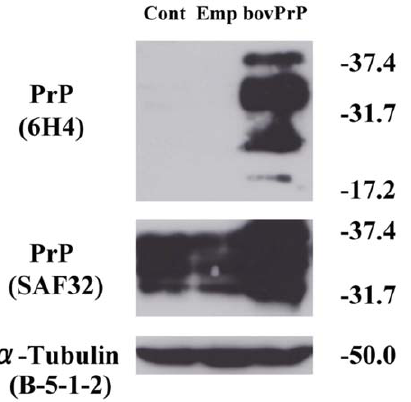
Figure 1. Expression of PrP in pEF-boPrP-transfected N2a cells. The bovine PrP expression vector pEF-boPrP was transfected into N2a cells. Forty eight hours after transfection, cells were lysed, and then the proteins were separated by 12% SDS-PAGE and blotted. The resulting blots were analyzed using anti-PrP mAb 6H4 as a specific antibody for bovine PrP protein, SAF 32 for PrP of all species, or B-5-1-2 for a -tubulin as an internal control.